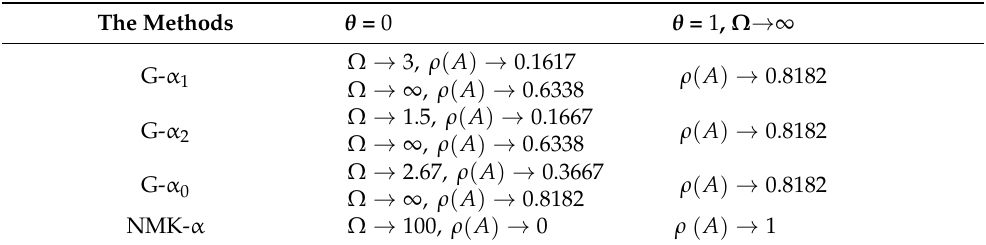
Table 2. Spectral radius ρ ( A ) calculated by the referred